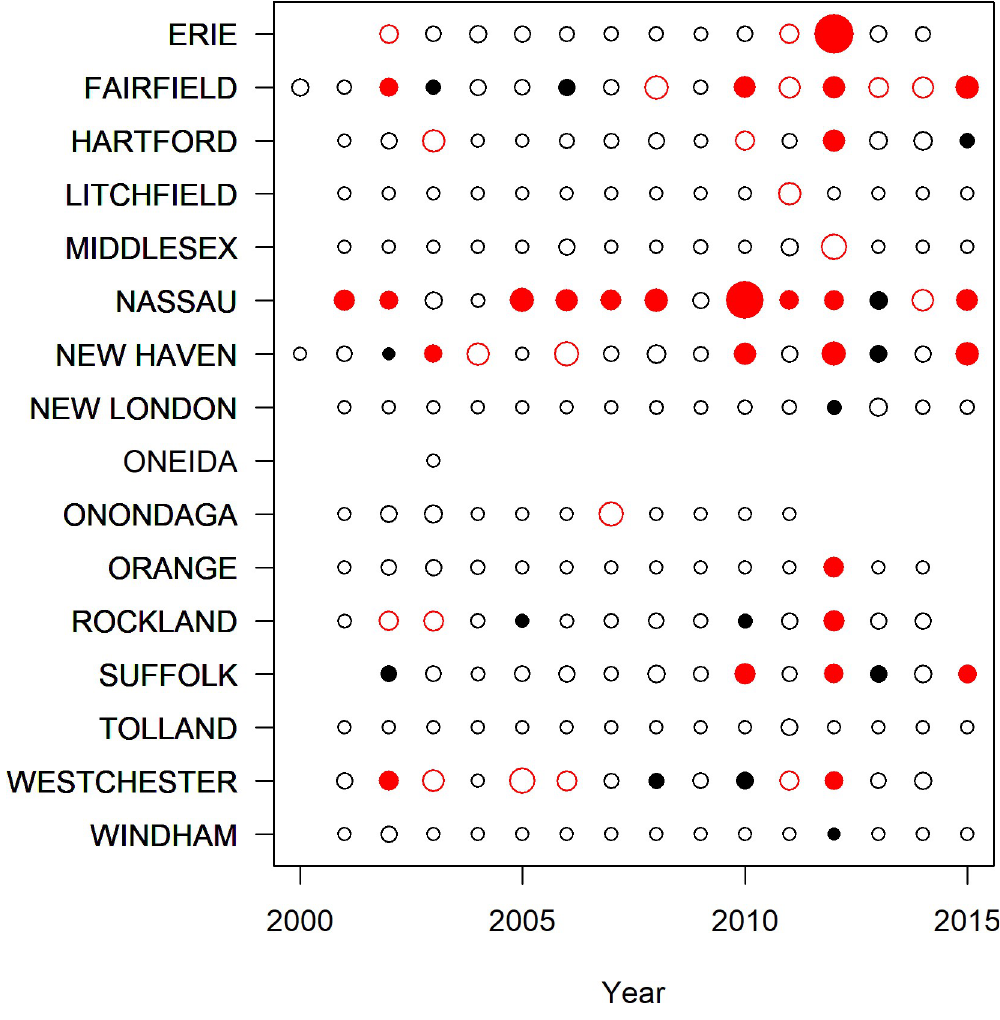
Fig 4. Predicted (unfilled � 5, filled > 5) and observed (black � 5, red > 5) infected mosquitoes per 1000 for each county and year for WNV. Missing points correspond to missing years for those counties. Point sizes are scaled relative to the observed infection